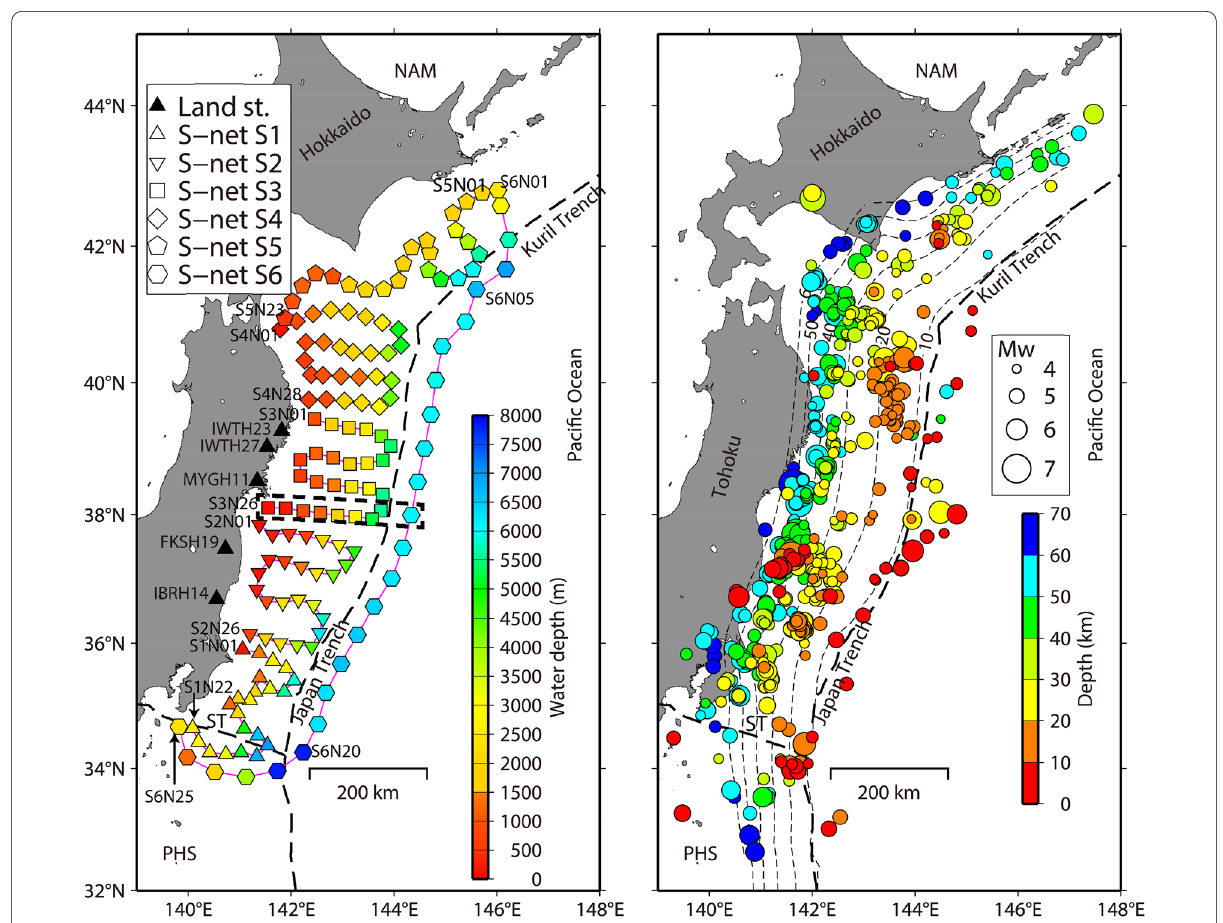
Fig. 1 Index maps. Left panel: black-filled triangles denote the recording stations on land (KiK-net) and color-filled polygons denote the recording stations on the ocean bottom (S-net). The six segments of the S-net (S1–S6) are denoted by different polygons, with station codes at the start and end of each segment. The short-dashed rectangle indicates the location of sites, namely, S3N26, S3N25, S3N24, S3N23, S3N22, S3N21, S3N20, S3N19, and S6N12 from left to right, respectively, discussed later. The NAM, PHS, and ST are shorthand for the North-American Plate, Philippine Sea Plate, and Sagami Trough, respectively. Right panel: location of the epicenters of earthquakes used in the present study. The depth to the Pacific Plate is marked with contours (thin dashed lines) at interval of 10 km. The 10 km contour coincides roughly with the Trench axes. The plate-depth data were taken from Hirose